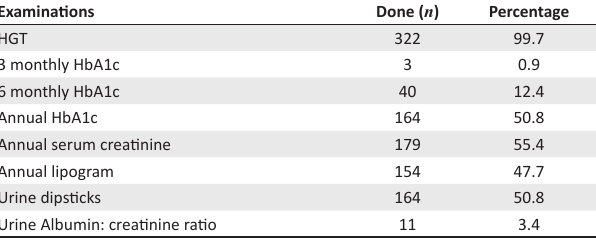
TABLE 4: Documented routine investigations, glycaemic and target organ damage in reviewed files ( N = 323). Examinations